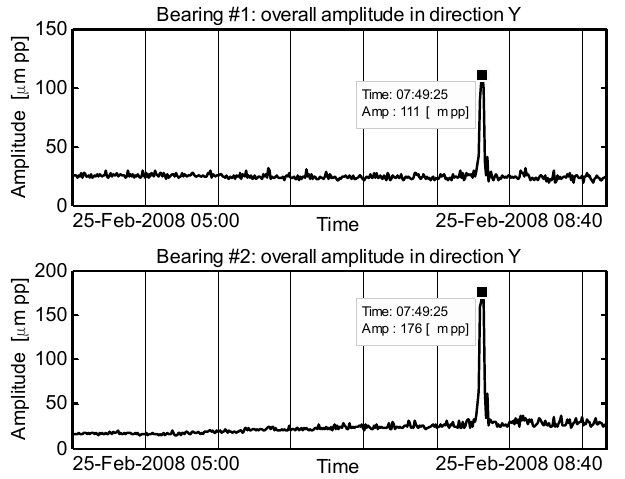
Fig. 7. Historic trend of the overall amplitude of the vibrations measured on the support #2 (direction Y) at the end of a load rise at the operating speed of 3000